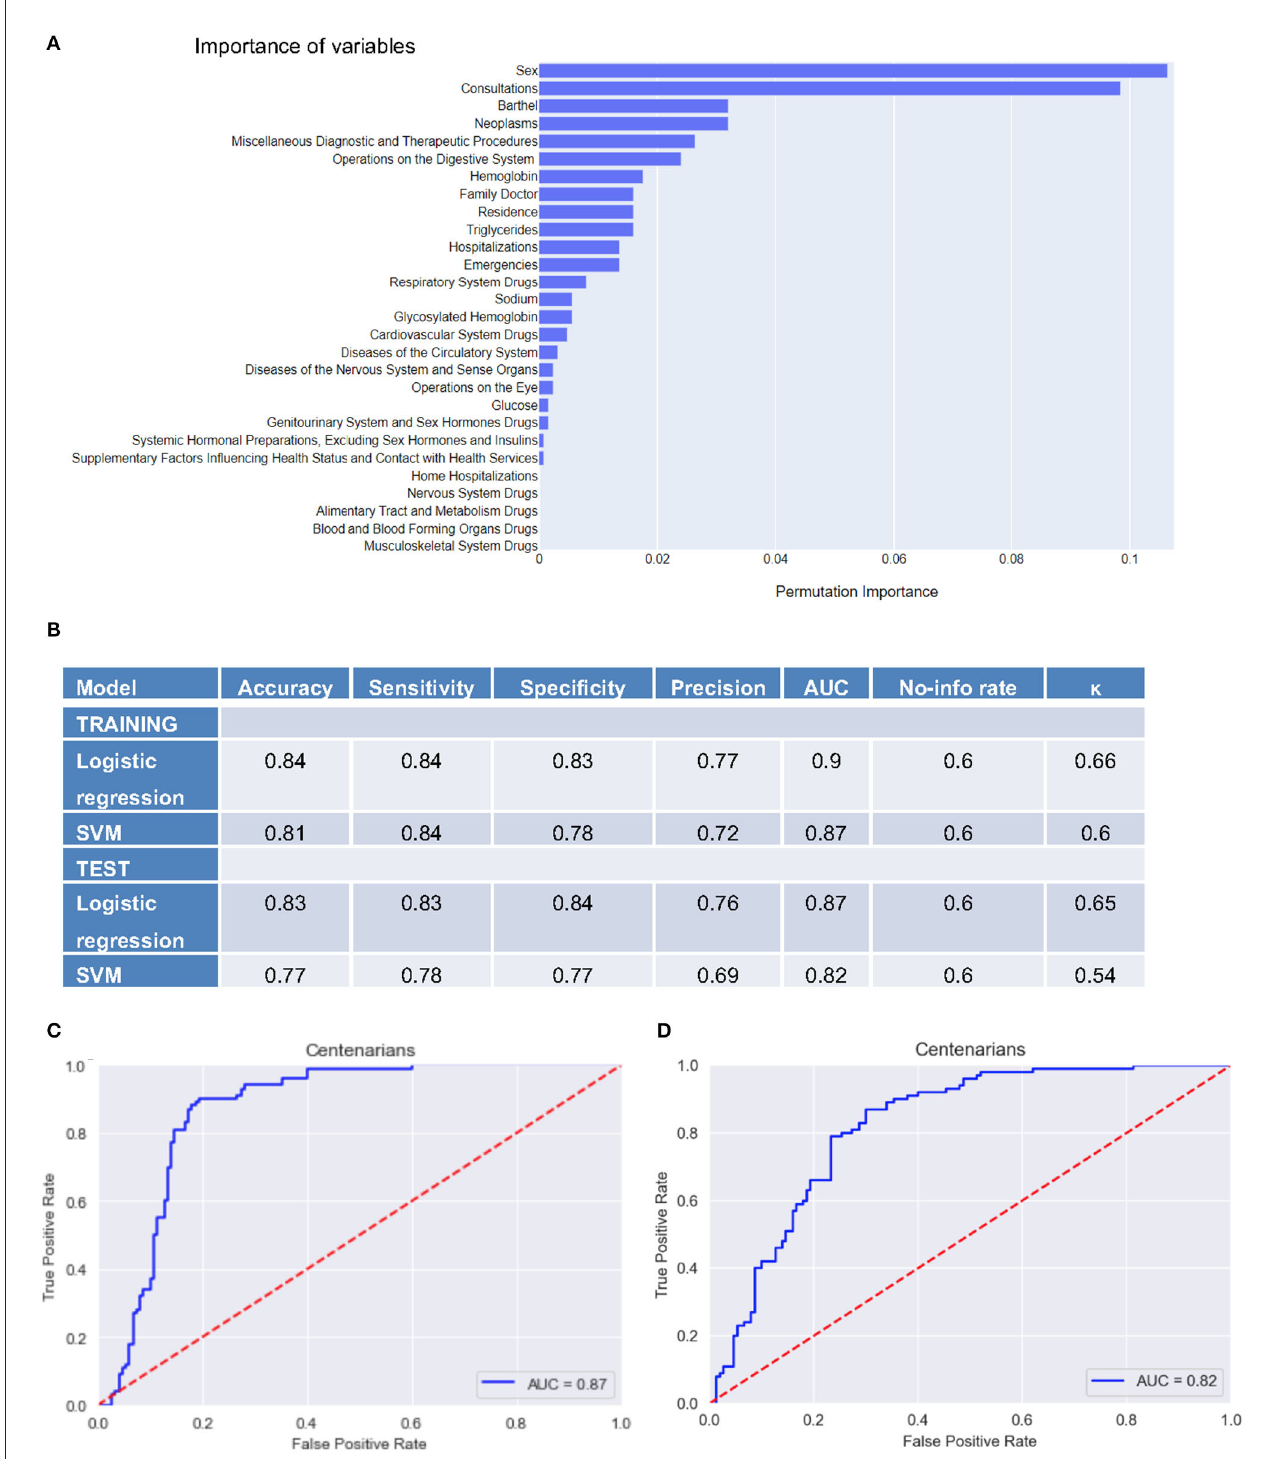
FIGURE1 Results from machine learning models. (A) Permutation importance of selected variables in the SVM model. Coefficients represent the decrease in the predictions when randomly shuffling the values of a given feature. (B) Performance of predictive models in centenarians and non-centenarians classification in validation datasets. (C) Logistic regression ROC curve, with an AUC of 0.87. (D) SVM ROC curve, with an AUC of 0.82.